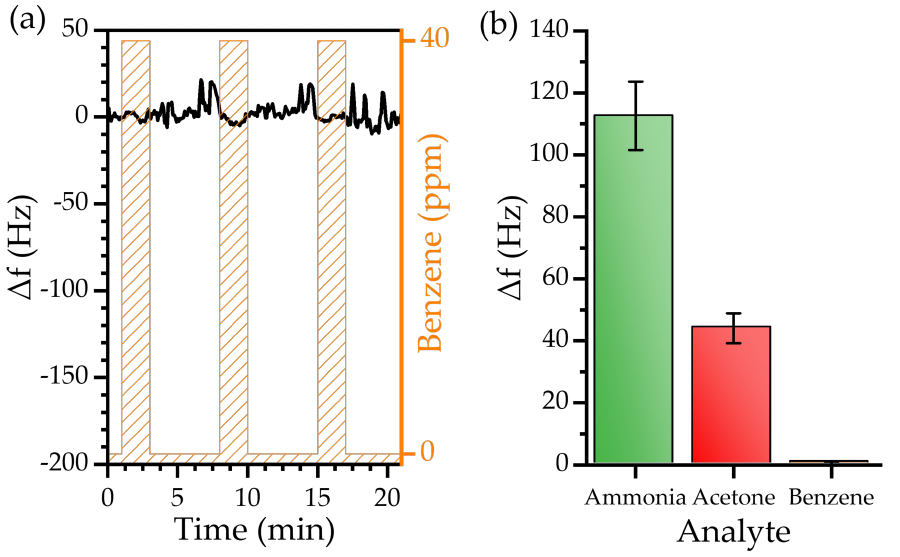
Figure 12. ( a ) Real-time frequency shift of the device exposed to 40 ppm of benzene (gas) and ( b ) comparison between the MEGS response to 40 ppm of ammonia, acetone, and